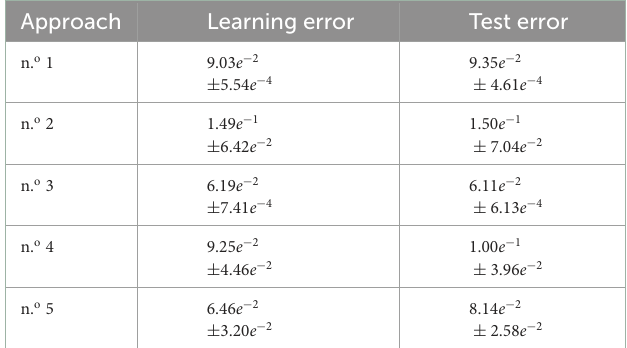
TABLE 1 Performances obtained on the in vitro